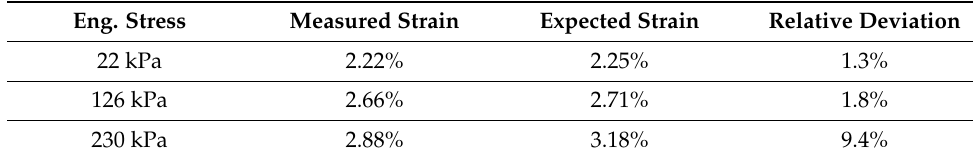
Figure 15. The experimental setup for measuring the characteristics of specimen 2 of the CORDEA ( a ). The applied voltage signal and the measured length plotted over the time for an attached weight that exerts a force of 2.17 N, corresponding to an engineering stress of 230 kPa, are shown in ( b ). The resulting actuation strain depending on the voltage for different constant loads is depicted in ( c ). The circles represent the expected strain based on the measurements of CORDEA specimen 1 shown in Figure 12. Table 3. Comparison of measured and expected